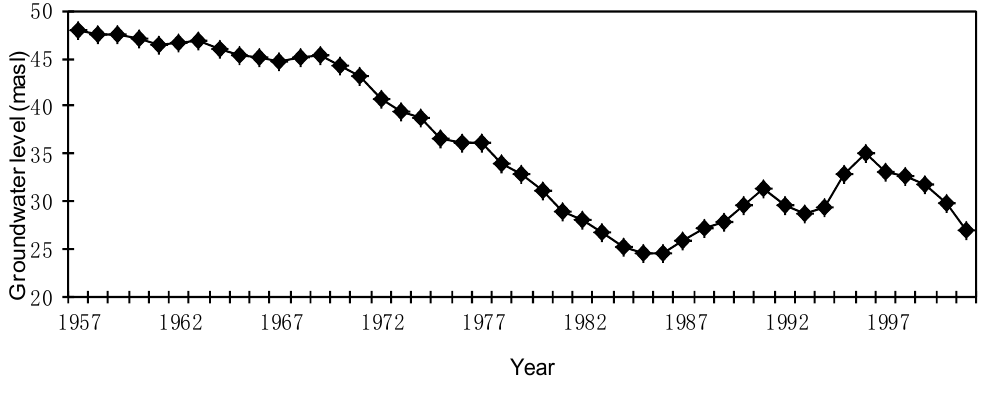
Figure 2. Precipitation rate in Beijing from 1986 to 2009 (Source: